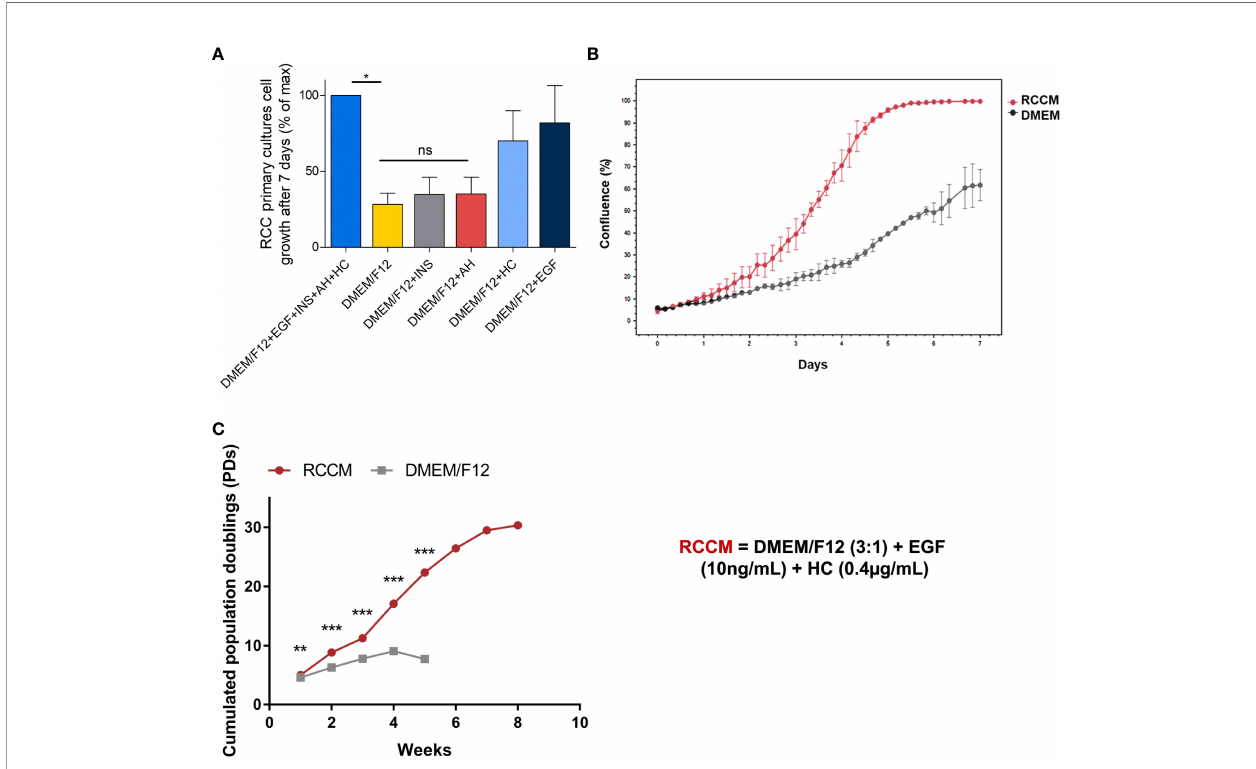
FIGURE 1 | Optimization of RCC cell growth with cytokines. Dissociated cells from ccRCC tumors from 3 patients were ampli fi ed in culture media containing the indicated cytokines. EGF: Epithelial Growth Factor, INS: insulin, AH: adenin, HC: hydrocortisone. RCCM: medium supplemented with EGF and HC. (A) 7-day proliferation index of ccRCC cells from 3 patients in media supplemented with the indicated cytokines. Maximum proliferation was obtained with the 4 cytokines added to the medium and constituted the 100% mark. All other proliferation results were indexed on this mark. (B) RCCM permits faster growth. Con fl uence % obtained with of primary ccRCC cells over 7 days in RCCM, compared with DMEM/F12 medium alone for one representative patient Con fl uence % was measured every 4 hours with the Incucyte S2 system and raw values are plotted. (C) RCCM permits long-term growth. Long-term FDTR ccRCC cell growth from one selected patient in RCCM or in DMEM/F12 medium alone were compared over an 8-week period. The numbers of population doublings (PDs) attained by cultures were calculated and are plotted. *p < 0.05; **p < 0.01; ***p < 0.001; ns, non-signi fi